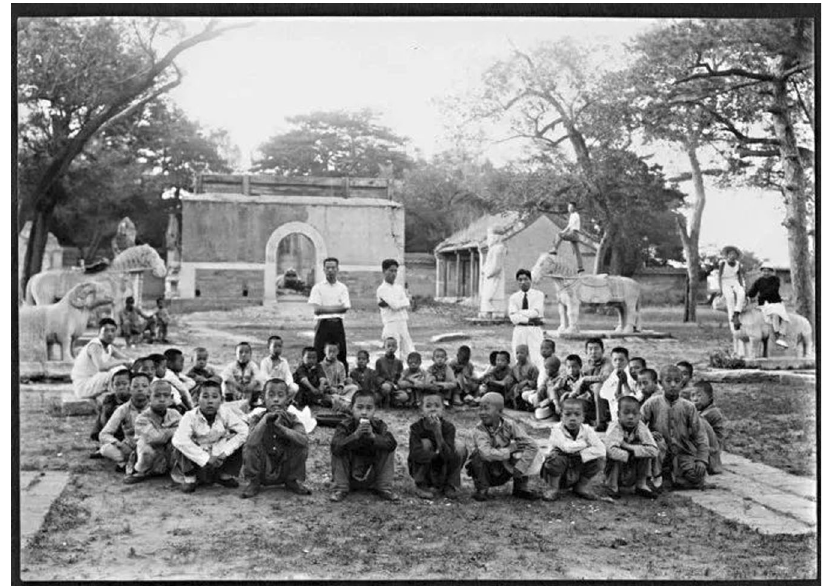
Fig. 1 An activity photo of the local service group of Yenching University. Between 1924 and 1926, the Yenching University Local Service Group carried out various social support activities in the Neizuo II district of Beijing. This is a group photo with the children after the